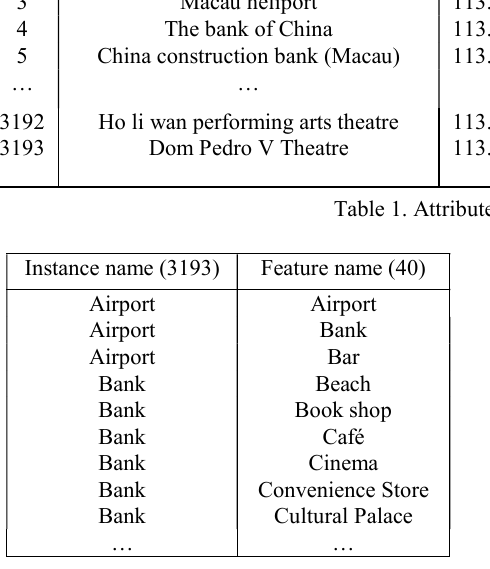
Table 2. Spatial object feature names